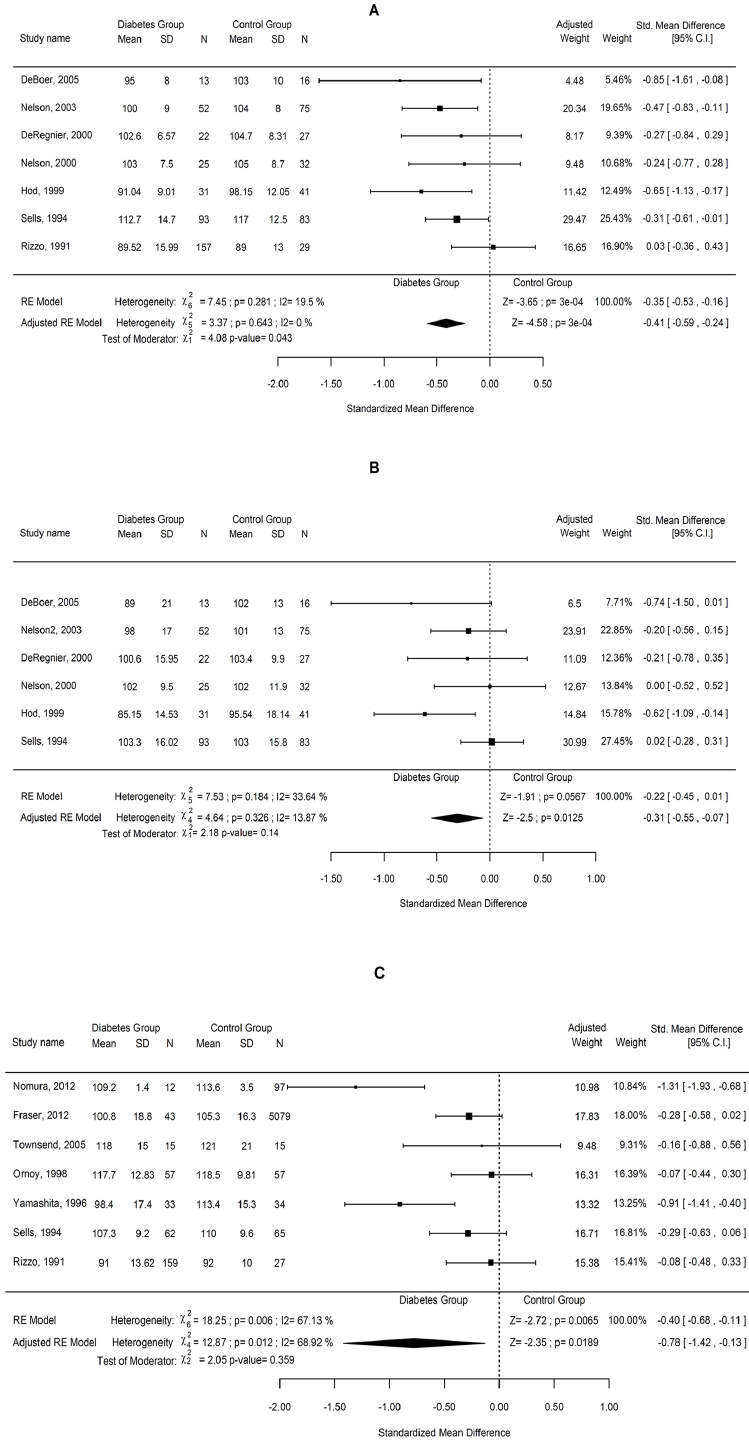
PLOS ONE | DOI:10.1371/journal.pone.0142583 November 13,